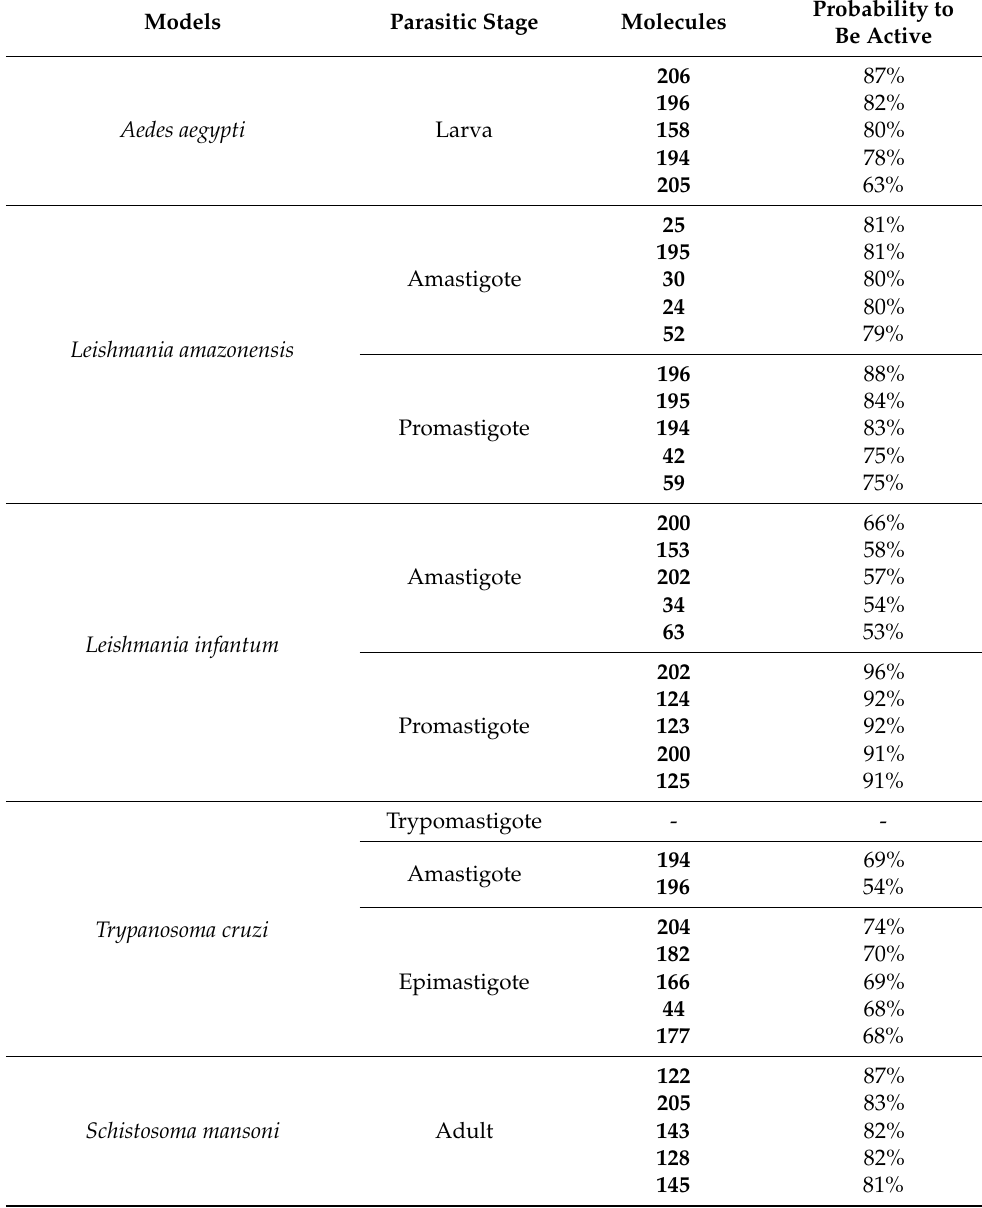
Table 11. Five molecules with the highest active potential probability of each model. Models Parasitic